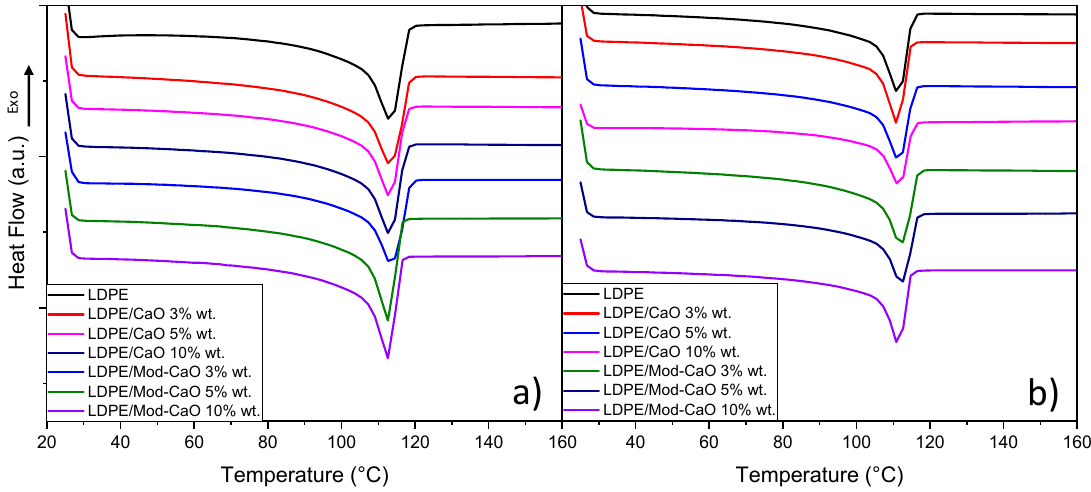
Figure 5. Differential scanning calorimetry of LDPE, LDPE/CaO, and LDPE/Mod-CaO nanocomposites with ( a ) 55 nm- and ( b ) 25 nm-size nanoparticles showing the crystallization temperature (Tc).